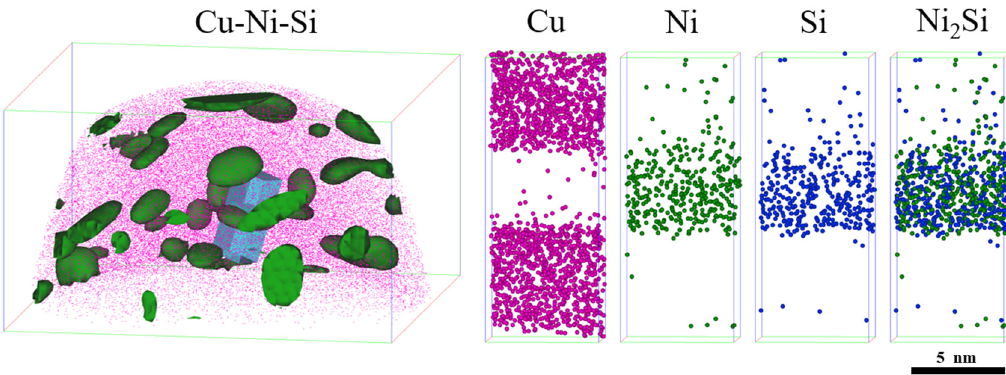
Figure 10. 3D atom maps of Cu, Ni, and Si atoms of the NS ‐ 4 alloy aged at 500 °C for 2 h.